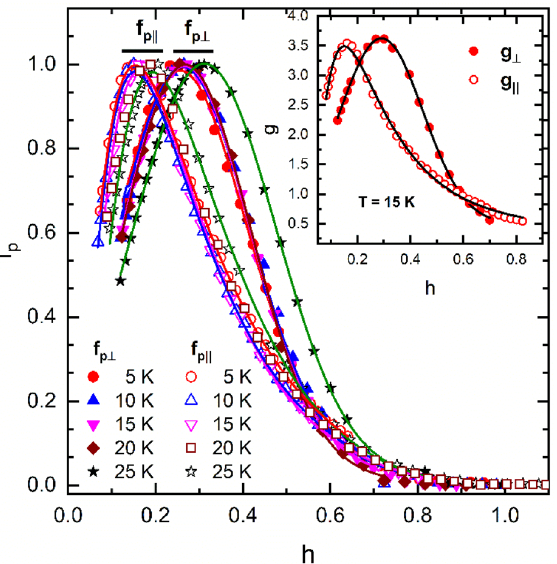
Figure 4. The dependence of the reduced pinning force f p on the reduced magnetic for the partially oriented MgB 2 sample ( v ) as measured in the parallel, f p||, and perpendicular, f p ⊥ , geometry in the temperature range 5–25 K. Continuous lines are the fits with Eq. (2). Insets present h -dependence of the functions g || and g ⊥ at T = 15 K. Continuous line is the fit with a Gaussian for g || and a lognormal function for g ⊥ .